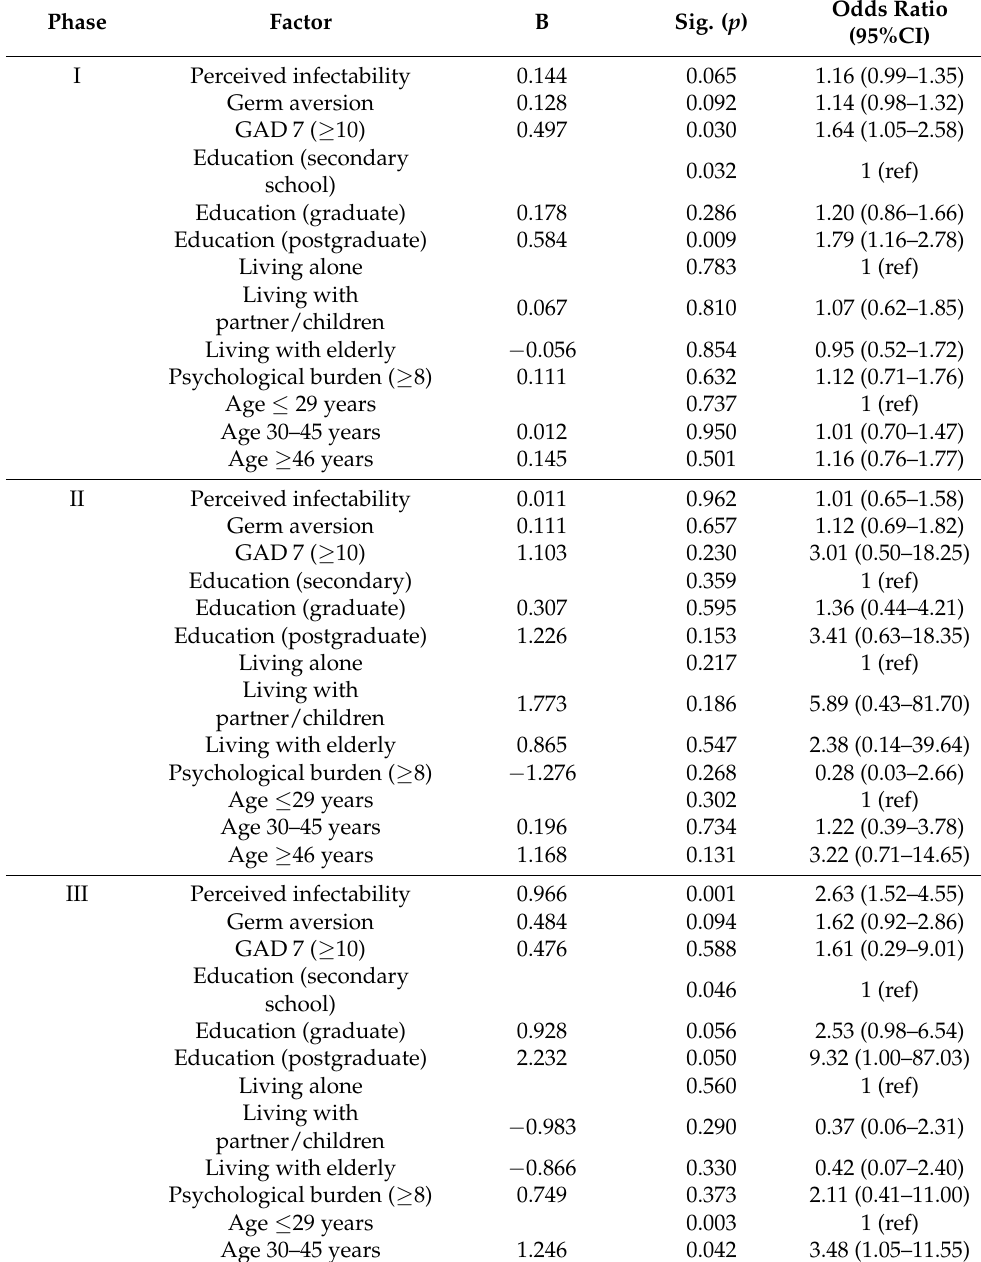
Table 4. Regression analysis of factors influencing vaccination intention in different survey